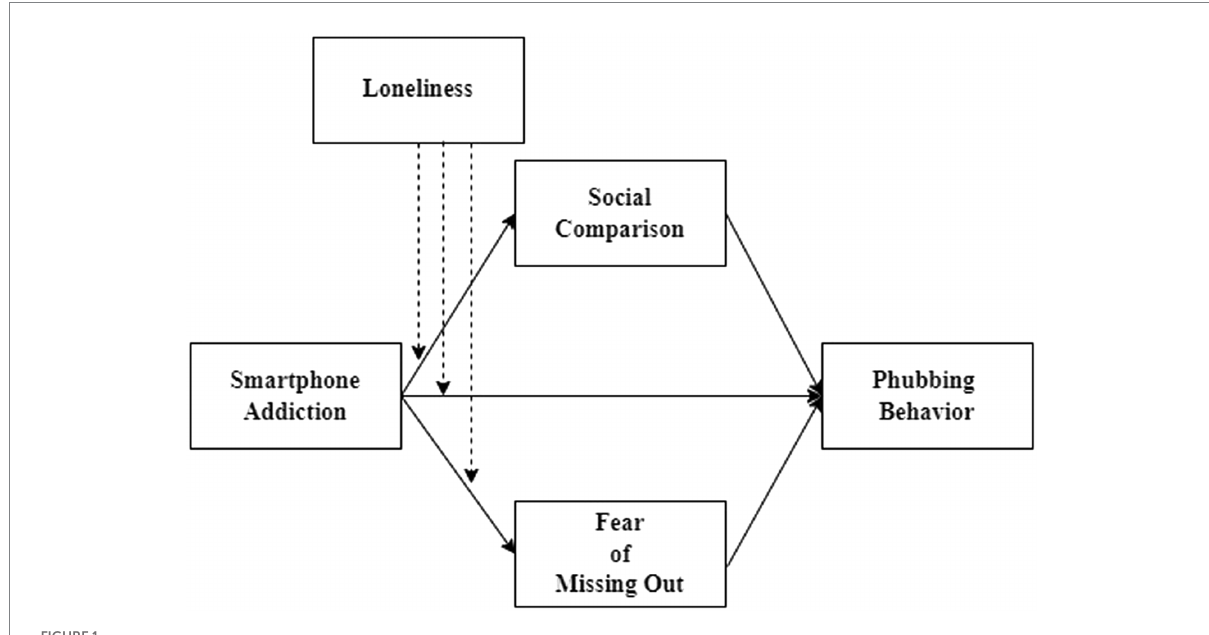
FIGURE 1 Research